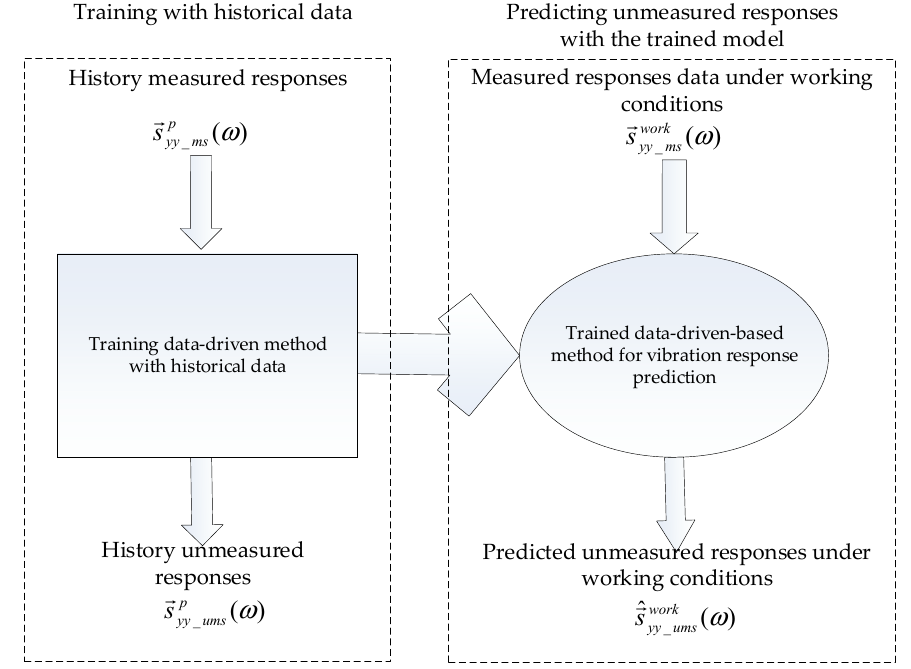
Figure 1. Data-driven multi-point vibration response prediction under unknown uncorrelated multi-source loads.